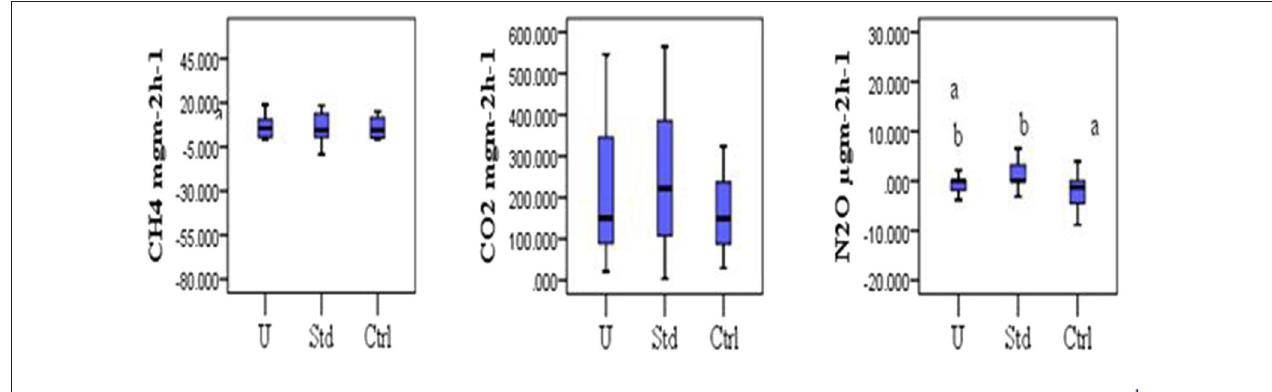
Pairwise comparison indicated that the significant difference was between control and standard fertilization.